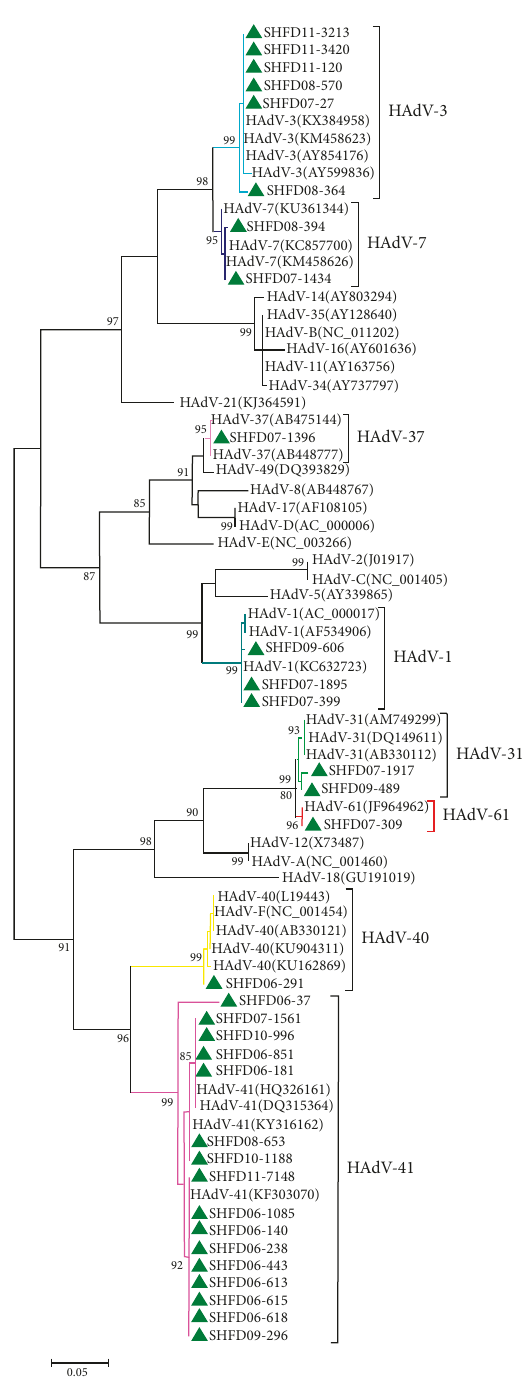
Figure 3: Phylogenetic tree based on partial nucleotide sequences (482 bp) of the hexon gene of HAdVs detected in hospitalized children with acute diarrhea in Shanghai, China, between January 2006 and December 2011. The delta symbol indicates the adeno- virus strains detected in this study.